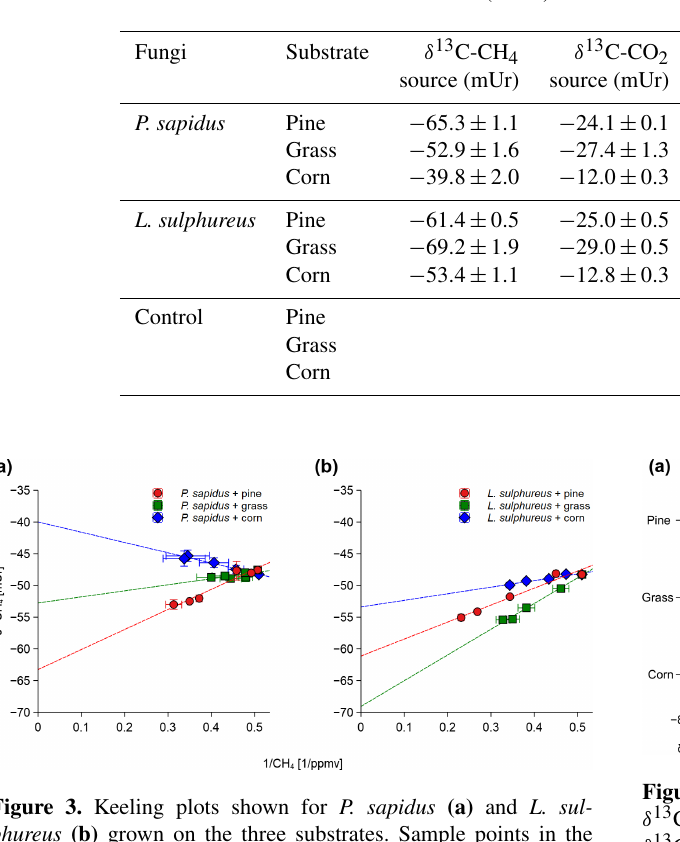
Table 2. Calculated δ 13 C-CH 4 and δ 13 C-CO 2 source signatures, δ 13 C values of the substrates, and ε app CH presented as mean values with their standard deviation ( n = 3).